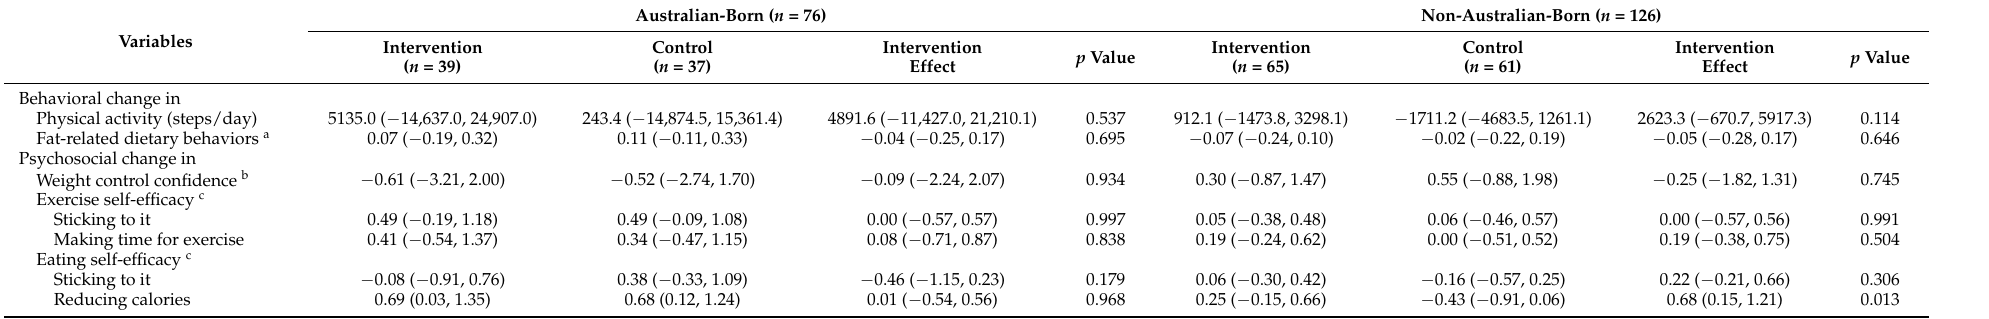
Table 2. Changes in behavioral and psychosocial measures from baseline to 6 weeks postpartum.